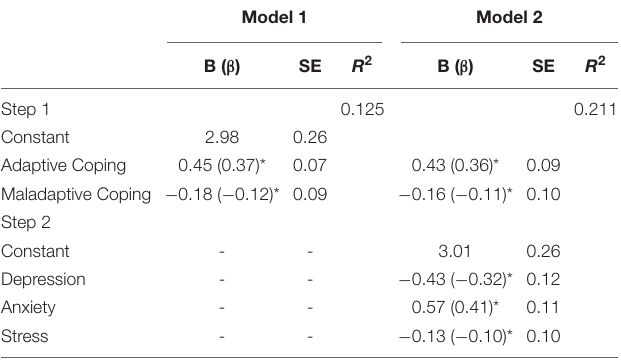
TABLE 3 | Hierarchical regression